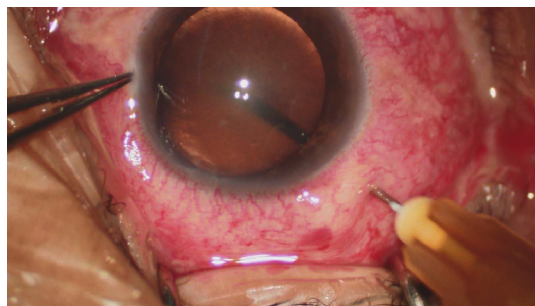
Figure 1: Vitreous aspiration was performed using a 27 gauge needle attached to a 1ml